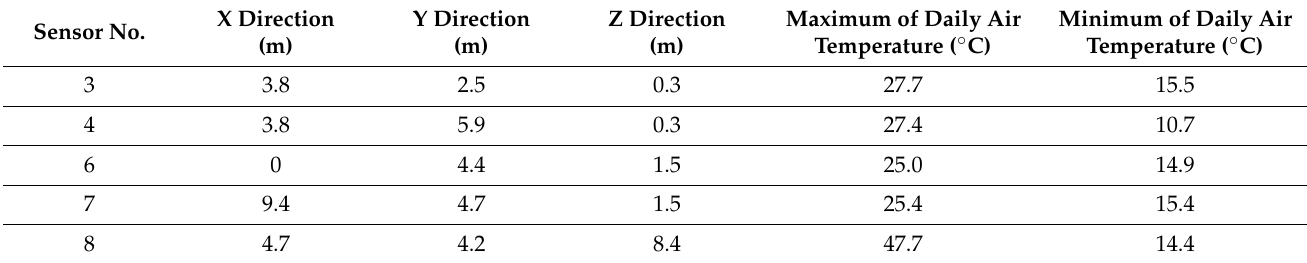
Table 1. Selected measurement results of the air temperature in the truss according to the sensor position on 3 June 2012. Sensor